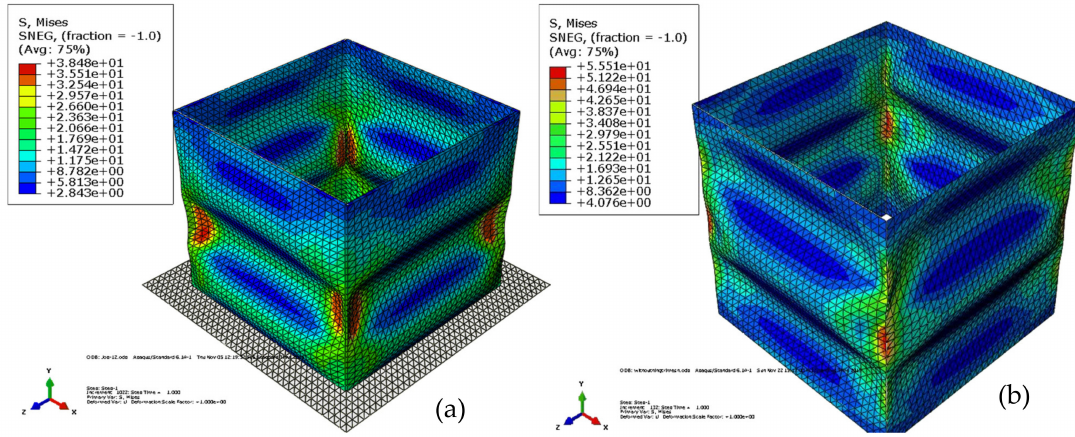
Figure 14. Von Mises stresses of the ( a ) creased and ( b ) uncreased cartons [155]. Reprinted with